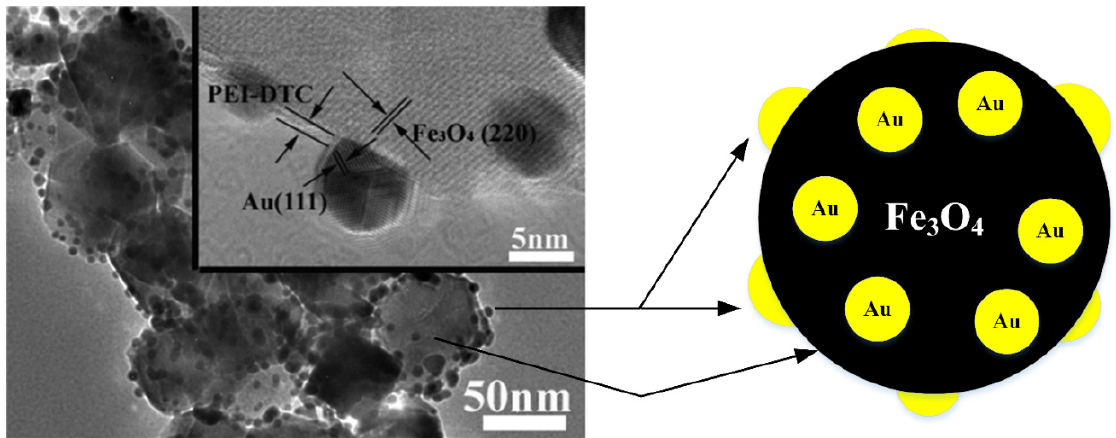
Figure 3 . TEM image [44] and schematic diagram for the preparation of core@satellite CsFe 3 O 4 @Au NPs.